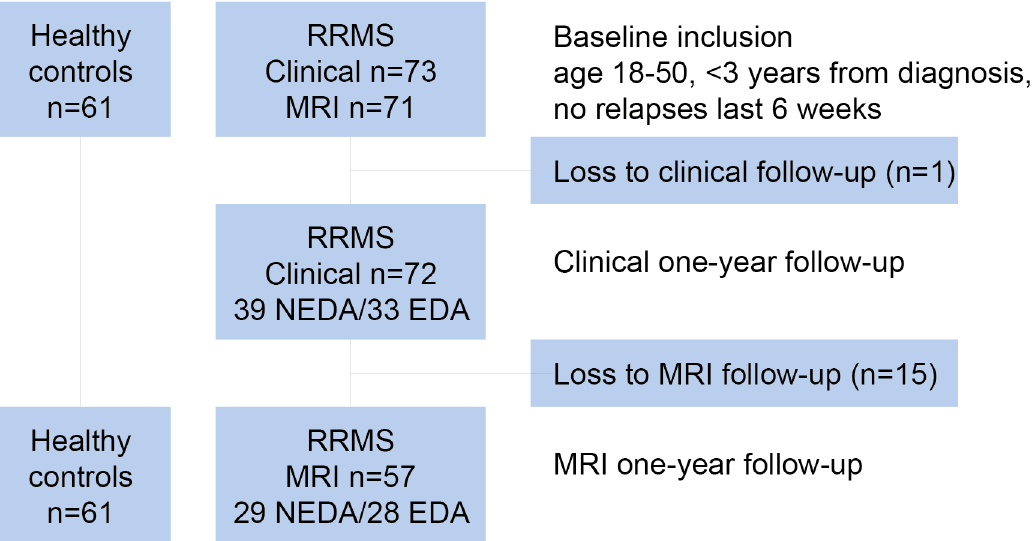
Fig 1. Flow chart of patients and controls. Loss to clinical follow-up: moved (n = 1). Loss to MRI follow-up: pregnancy (n = 4), no contact/declined to participate (n = 3), moved (n = 2), incomplete MRI (n =